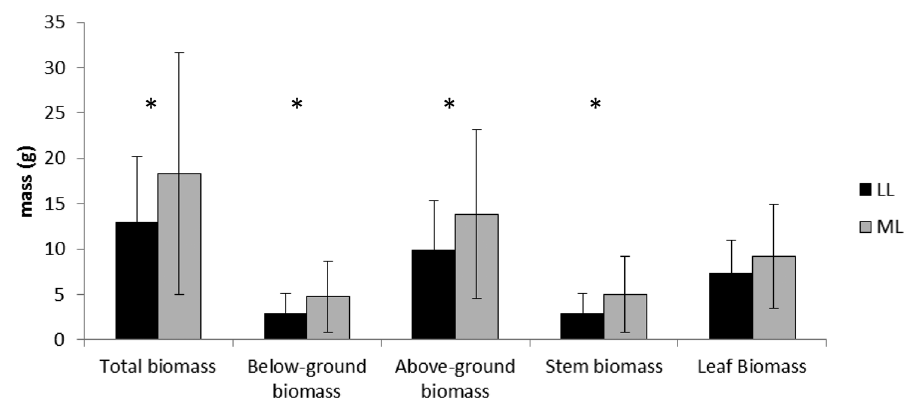
Figure 3. Average total, below-ground, above-ground, stem and leaf biomass of Guioa semiglauca seed- lings grown under medium (ML) and low (LL) light conditions. Asterisks denote where significant dif- ferences lay. Table 2. Probability values for ANOVA tests for effects of competition and light on accumulated dry bio- mass and leaf characteristics for 4 species of lianas. Degrees of freedom are shown next to the first species. Probabilities in bold represent significant differences at α = 0.05.